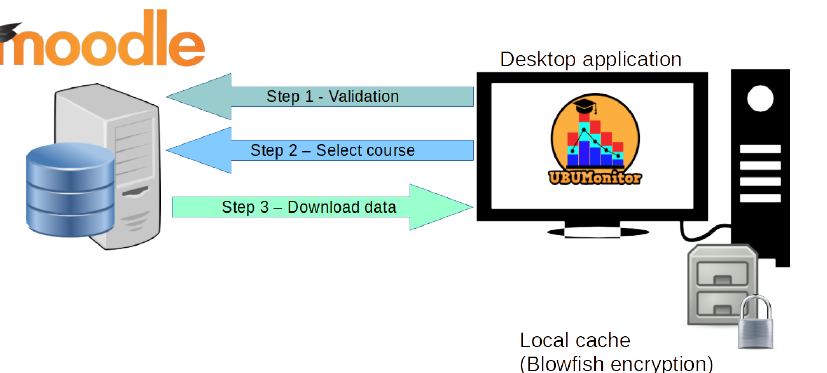
Figure 3. UBUMonitor’s architecture with